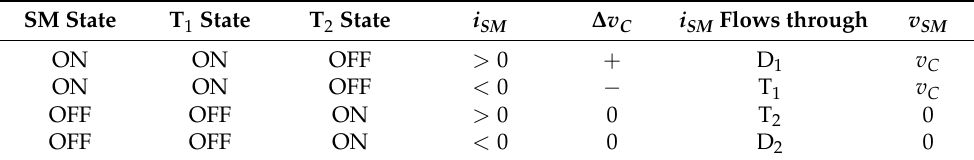
Table 1. Variables and states of a half-bridge (HB) switching module (SM)